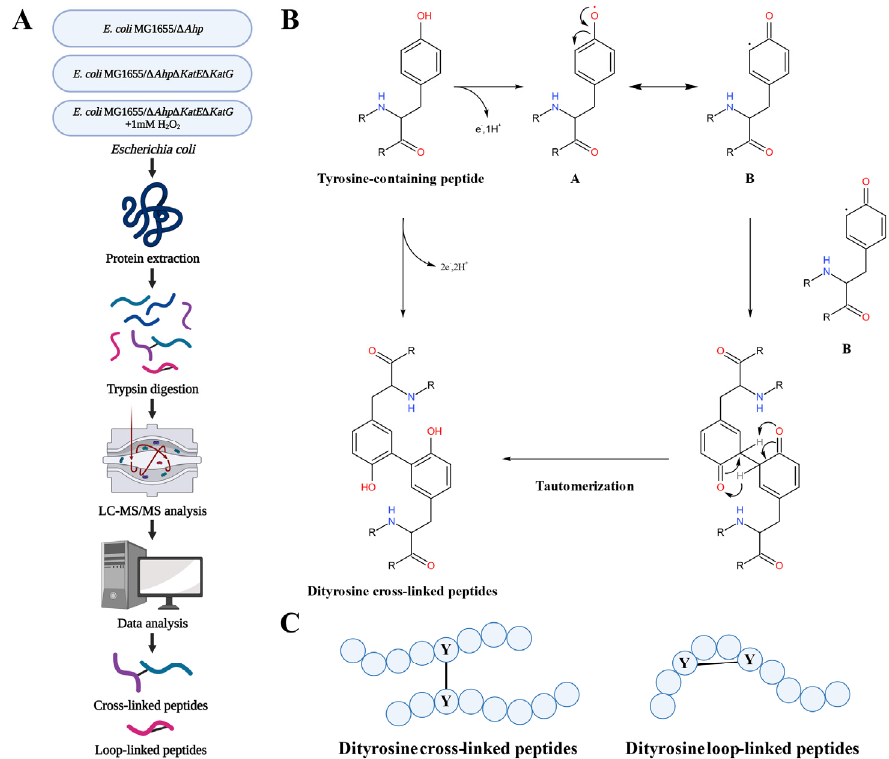
Figure 1. The identification, formation, and type of dityrosine crosslinking. ( A ) Experimental flowchart for the comprehensive analysis of dityrosine crosslinking in E. coli . The cartoon was created with BioRender.com (accessed on 6 February 2023). ( B ) The possible reaction mechanism of how dityrosine-crosslinked peptides were formed from tyrosine-containing peptides. ( C ) Schematic diagram of dityrosine-crosslinked peptides and dityrosine-loop linked